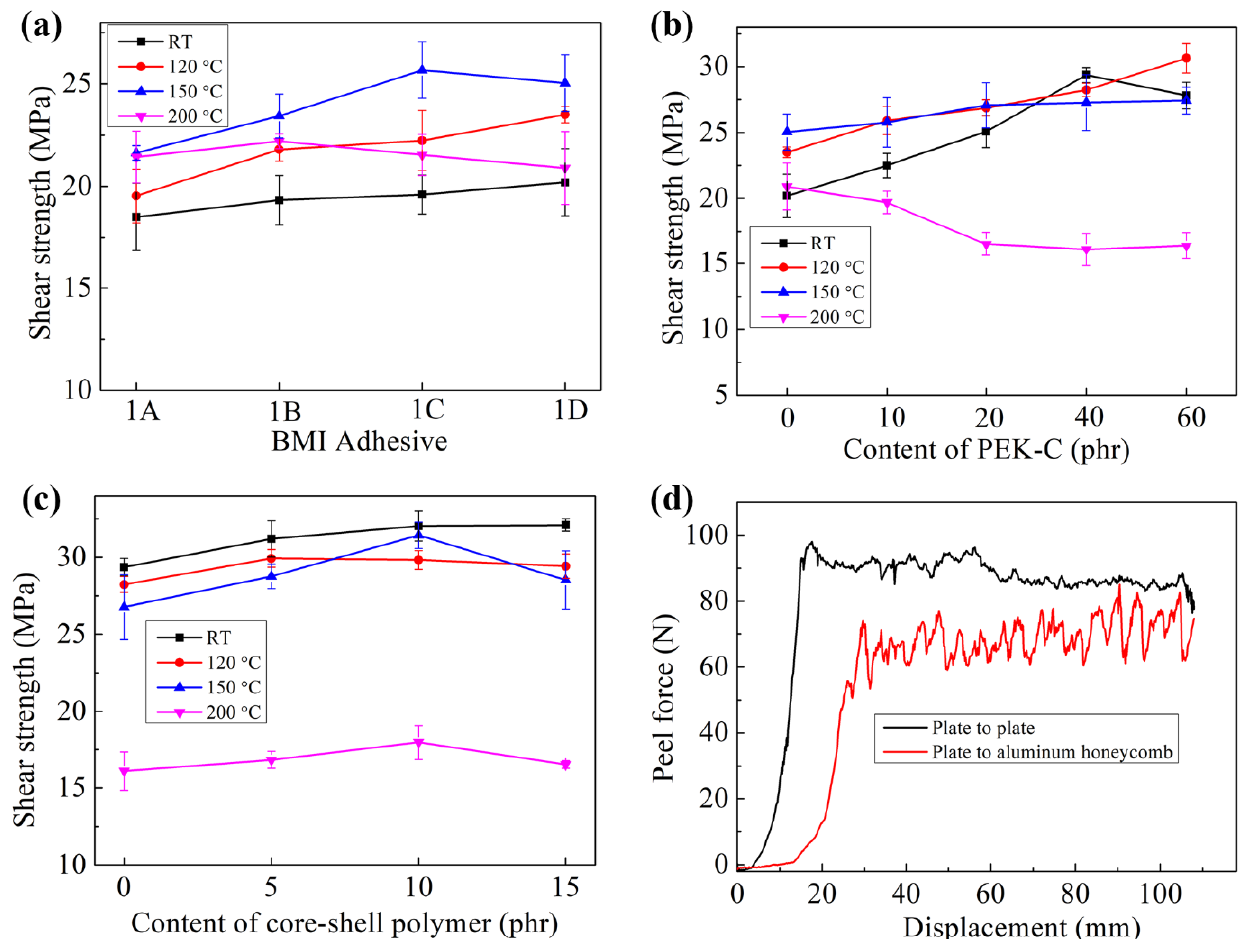
Figure 7. Bonding performance of different modified BMI adhesives. ( a – c ) Shear strength of the structural BMI adhesives under different temperatures. ( d ) Peel performance of the optimized structural BMI adhesives (23 °C).